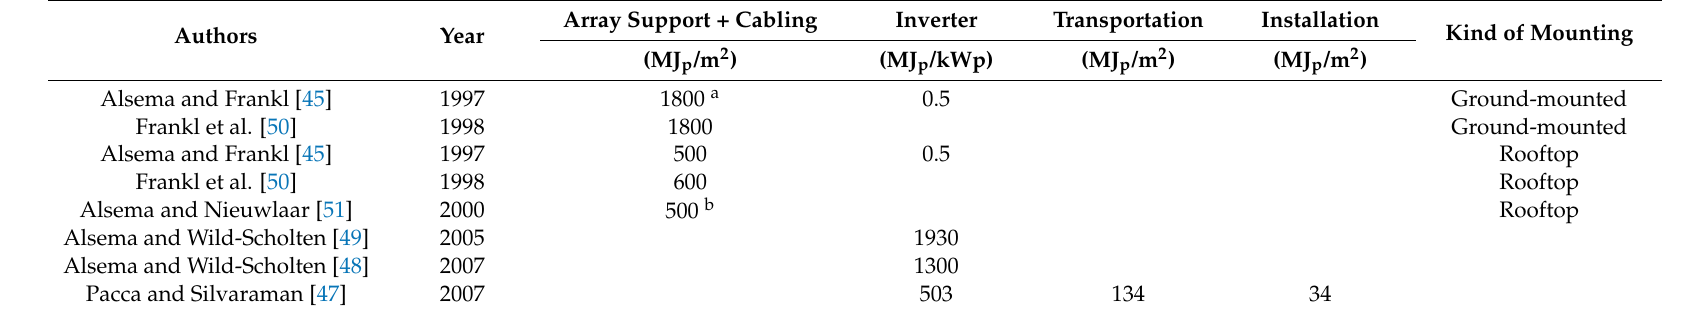
Table 2. Energy requirement of balance of system (BOS)